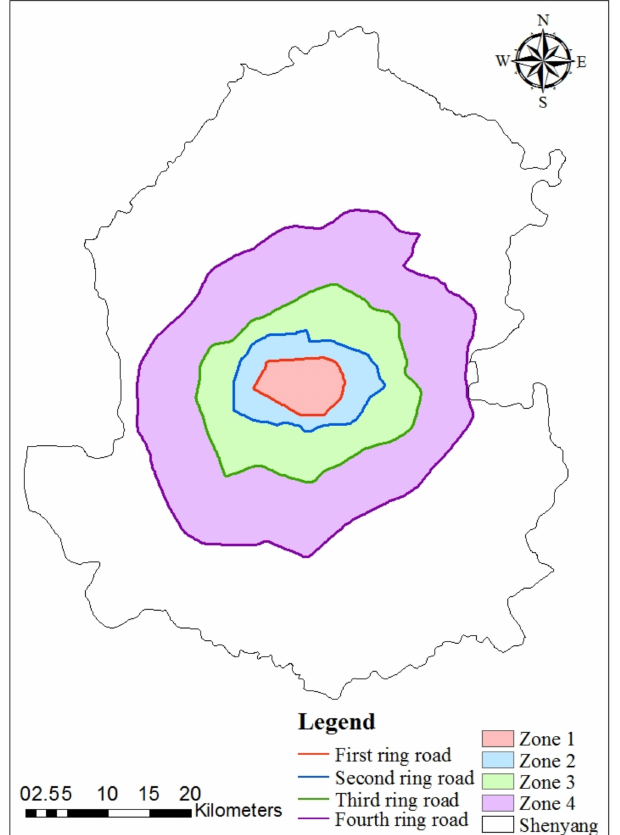
Figure 1. Regional location of study area, with four zones divided by four ring roads. Zone 1 is encircled by the first ring road. Zone 2 is the area between the first and second ring roads. Zone 3 represents the area between the second and third ring road. Zone 4 is the area between the third and fourth ring road. The four-ring area is the entire area of Zones